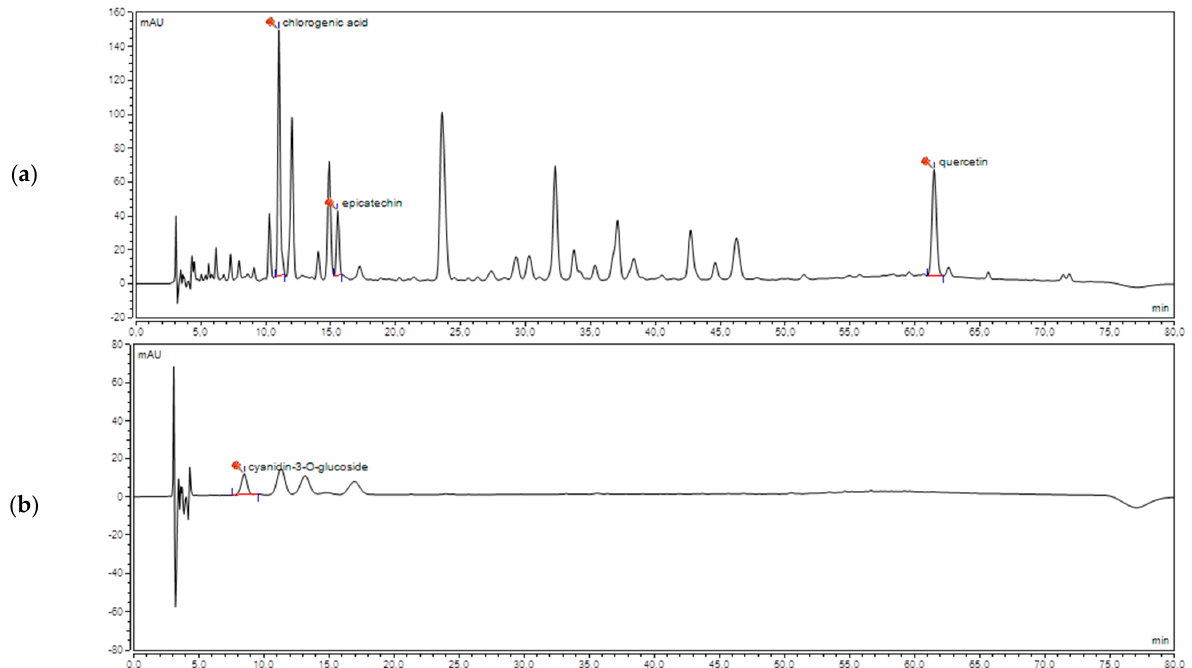
Figure 1. The chromatogram of cranberry juice (CJ): detection wavelength 270 ( a ) and 520 ( b ).